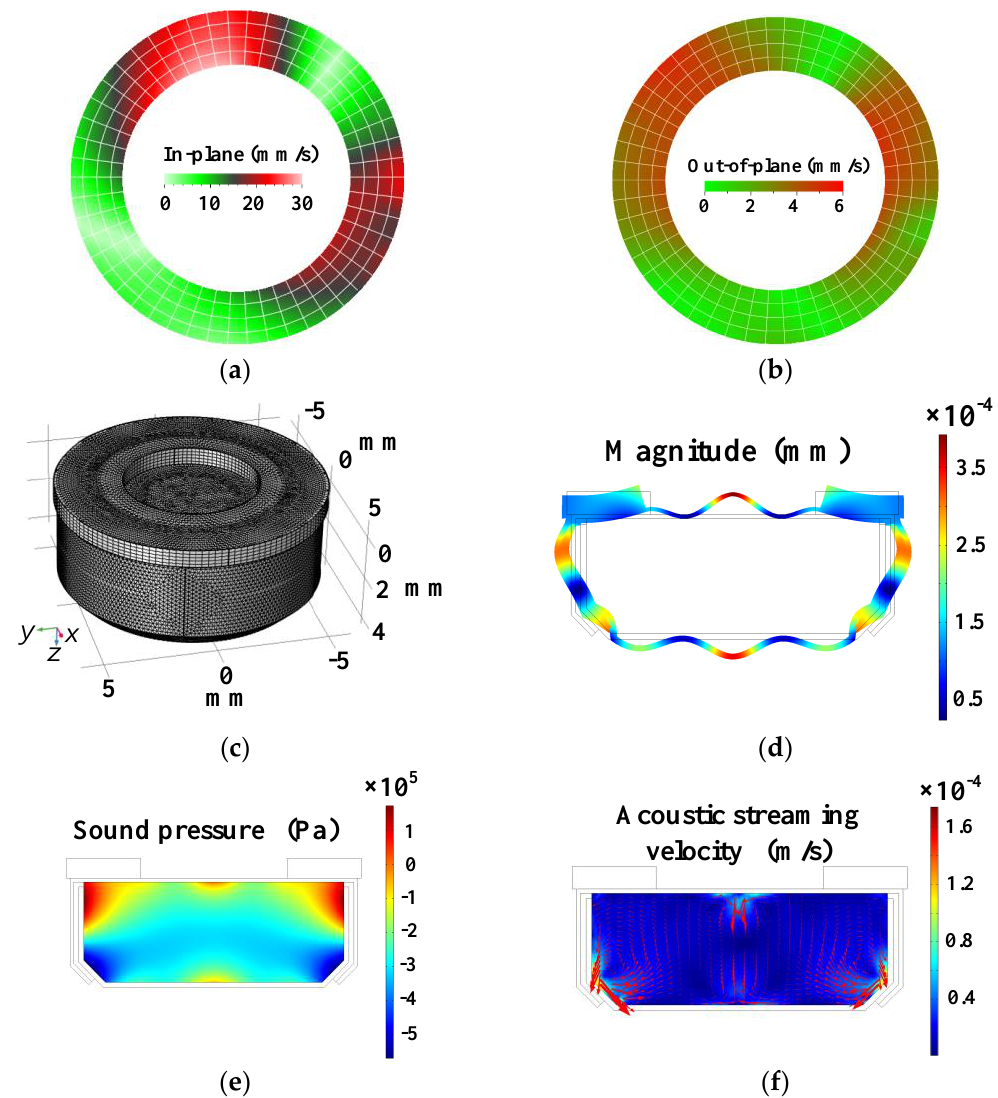
Figure 4. Measured vibration distribution at 161 kHz and 18 V p-p and computed acoustofluidic field in the battery. ( a ) The in-plane vibration of the piezoelectric ring’s top surface. ( b ) The out-of-plane vibration of the piezoelectric ring’s top surface. ( c ) A 3D grid meshed model of the battery. ( d ) Vibration displacement pattern of the battery. ( e ) Sound pressure distribution in the central plane of the inner cavity. ( f ) Velocity distribution of acoustic streaming in the central plane of the inner cavity.